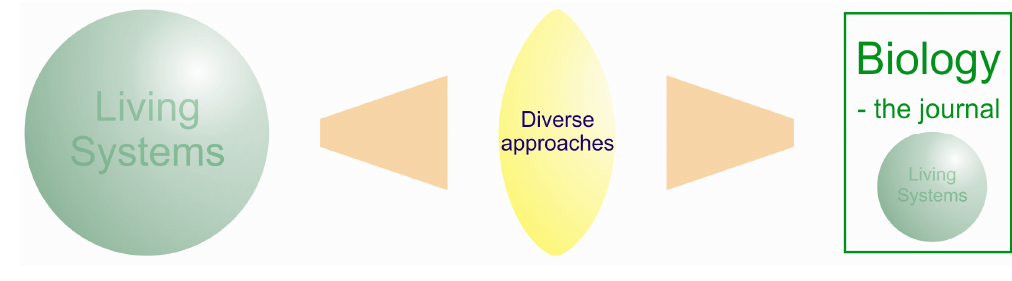
Figure 1. Biology will be an inclusive journal. Living systems are studied through the lenses of many diverse experimental and theoretical approaches and this journal will feature insight from this wide range of